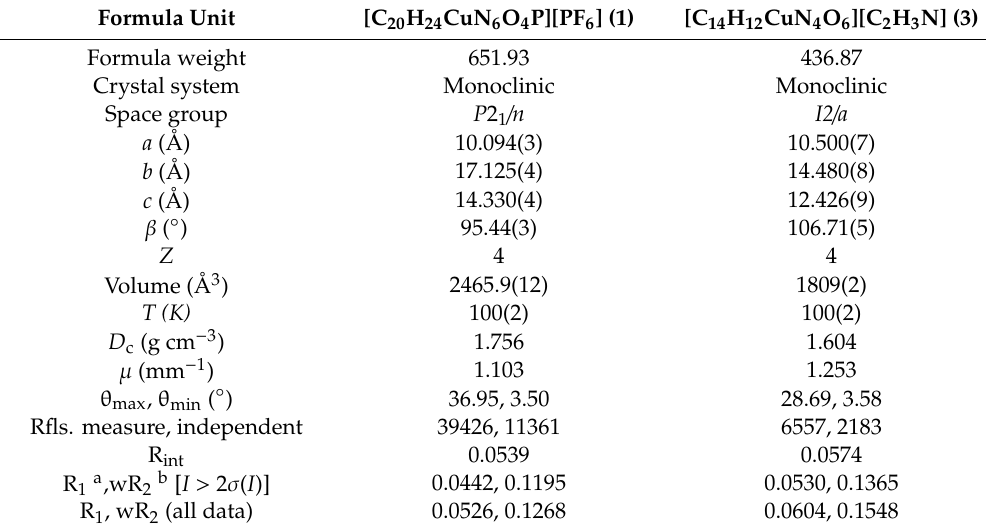
Figure 3. The π - π stacking interactions represented in red dashed line in compound 1 ( A ) and compound 3 ( B ). Table 1. Crystal data and structure refinement